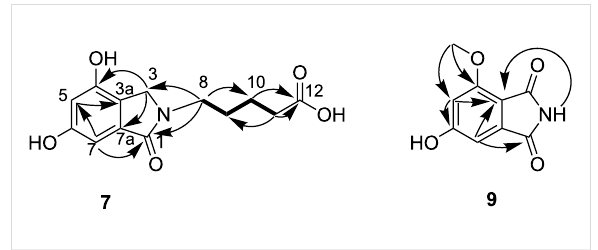
Figure 3: 1 H, 1 H COSY (bold) and selected HMBC (arrow) correlations of 7 and 9 .